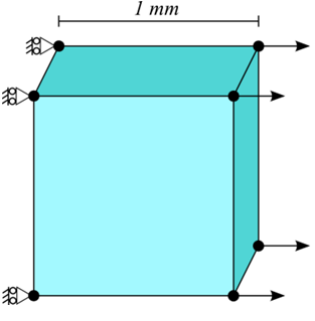
Fig. 2 Unit element